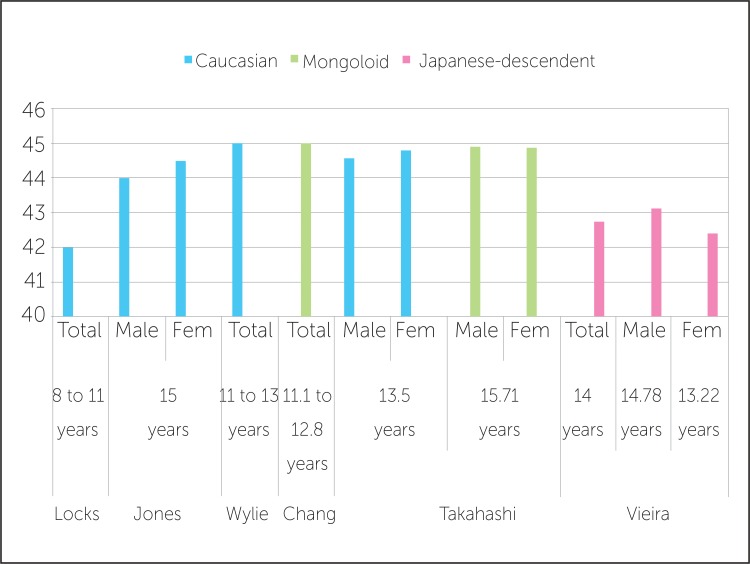
Means of UAFH - TAFH.